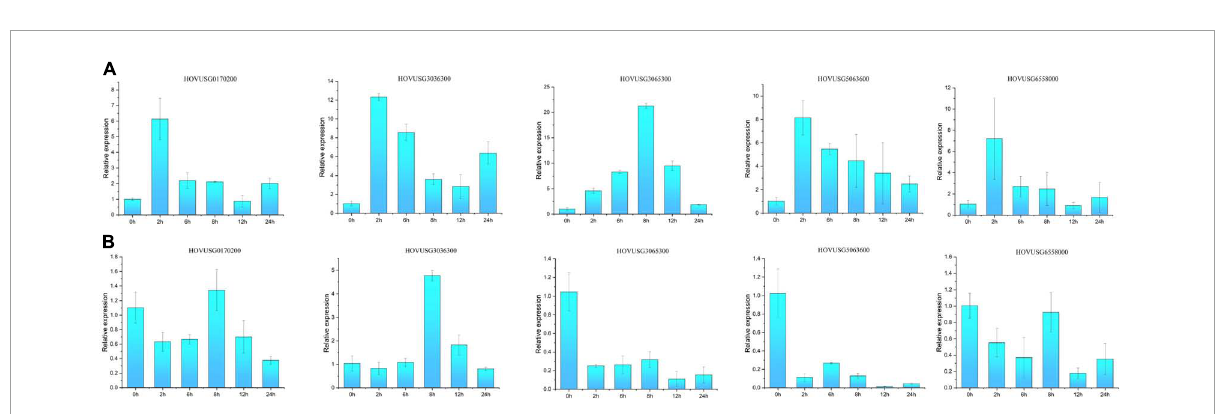
FIGURE8 Relative expression levels of TLP genes responding to sodium salicylate (SA) and methyl jasmonate (MeJA) treatments. (A) Expression patterns of HOVUSG6558000 , HOVUSG3036300 , HOVUSG0170200 , HOVUSG3065300 and HOVUSG5063600 in response to the SA treatment. (B) Expression patterns of HOVUSG6558000 , HOVUSG3036300 , HOVUSG0170200 , HOVUSG3065300 and HOVUSG5063600 in response to the MeJA treatment. The expression level of the untreated control (0 h) was used to calculate the relative expression levels at different time-points after imposing the hormone treatments. Bars are the mean ± SD of expression levels obtained from three independent biological